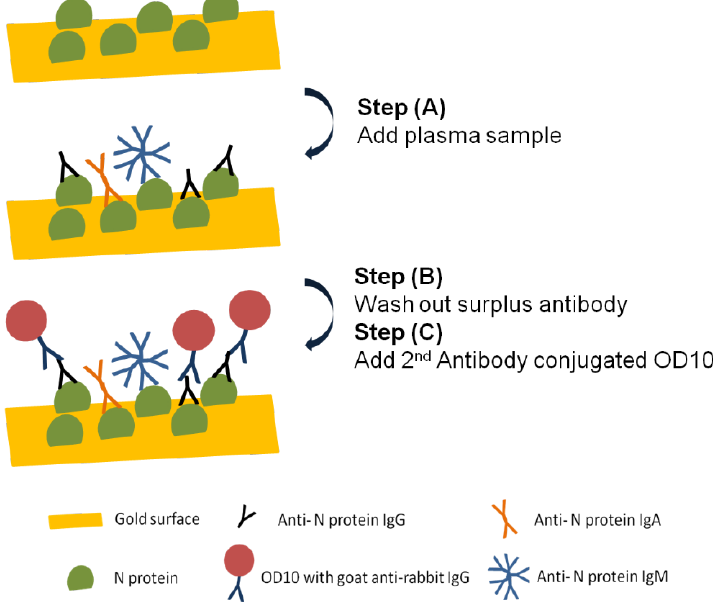
Figure 3. Schematic diagram of measurement protocol for anti-N protein IgG detection on N protein coated SH-SAW biosensor chip. (A) 5 µ L of sample was added onto the chip coated with SARS-CoV-2 nucleocapsid proteins; (B) the chip was rinsed with PBS to remove the nonspecific-bound proteins; (C) 5 µ L of detection antibody conjugated to AuNP was added.